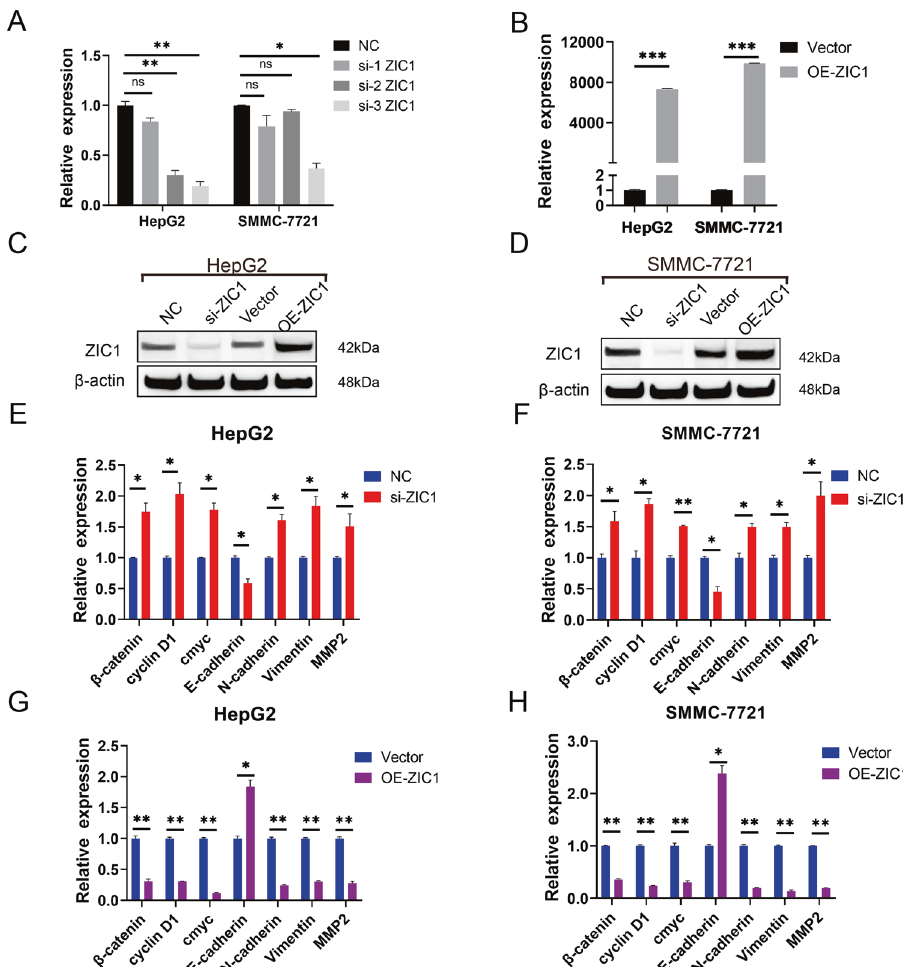
Fig. 6 Modulation of ZIC1 and the effect on the indicated downstream mediators of Wnt/ β -catenin signaling and EMT. A – D SMMC-7721 and HepG2 cells were transfected with ZIC1 siRNAs or ZIC1-overexpressing plasmid (OE-ZIC1). A , B Analysis of ZIC1 expression via RT-qPCR. C , D Analysis of ZIC1 expression via western blot. Vector: the empty pcDNA3.1( + ) plasmid. E , F β -catenin, cyclin D1, c-myc, E-cadherin, N- cadherin, Vimentin, and MMP2 mRNA expression were detected via RT-qPCR after transfection with si-ZIC1. G , H β -catenin, cyclin D1, c-myc, E-cadherin, N-cadherin, Vimentin, and MMP2 mRNA expression were detected via RT-qPCR after transfection with OE-ZIC1. Data were presented as mean ± SD of three independent experiments, * P < 0.05, ** P < 0.01, *** P <